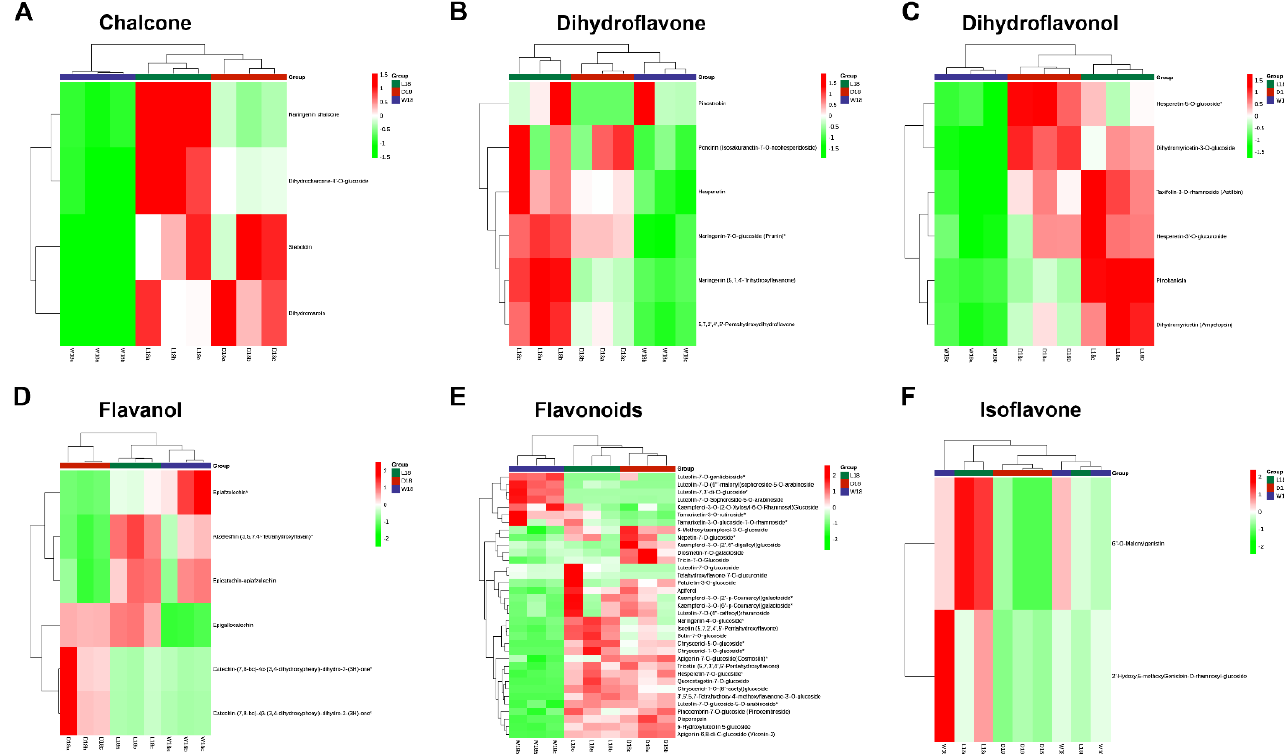
Figure 3. Clustering analysis of DEMs. ( A ) Chalcone DEMs. ( B ) Dihydroflavone DEMs. ( C ) Dihy- droflavonol DEMs. ( D ) Flavonol DEMs. ( E ) Flavonoids DEMs. ( F ) Isoflavone DEMs. Red color rep- resents up-regulation of differentially expressed metabolites and yellow represents down-regula- tion of differentially expressed metabolites. L18, D18, and W18 represent deep brown fiber, light brown fiber, and white fiber at 18 DPA.